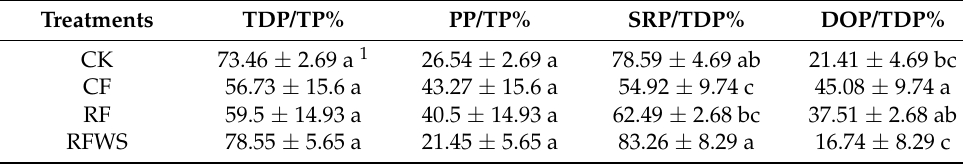
Table 3. The proportion of different forms of P in the overlying